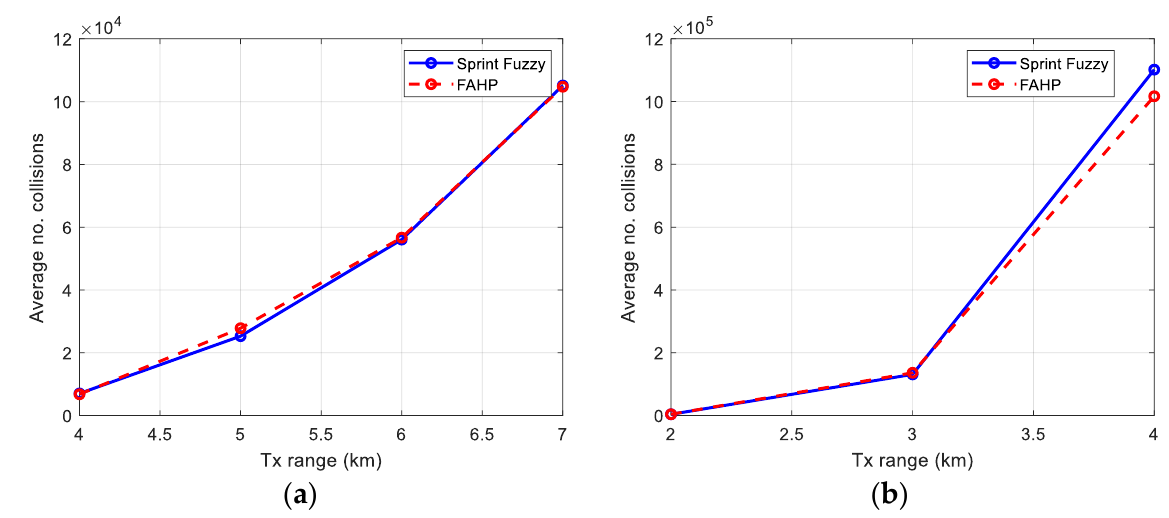
Figure 10. Average number of collisions. Number of nodes: ( a ) 100, ( b ) 400. of Figure 10. Table 11. Statistical comparison for average No.